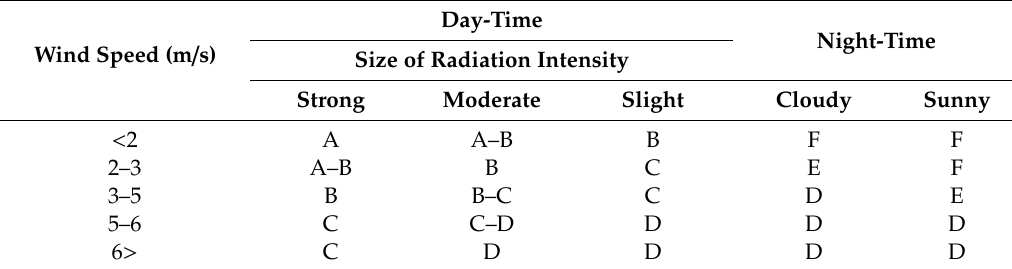
Table 4. Meteorological stability for Pasquill’s